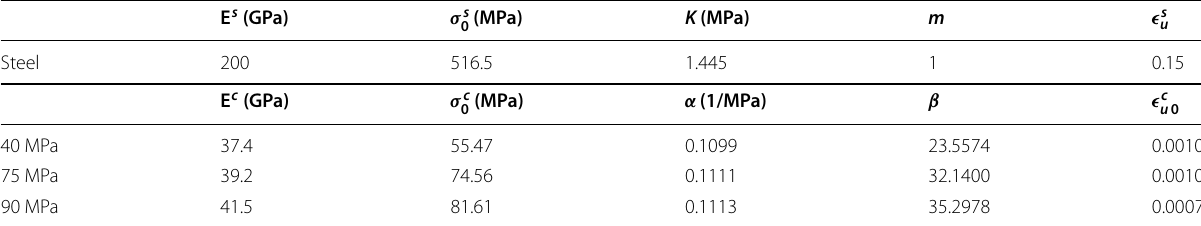
Table 2 Material properties for steel and for the three concrete grades used in the four point bending